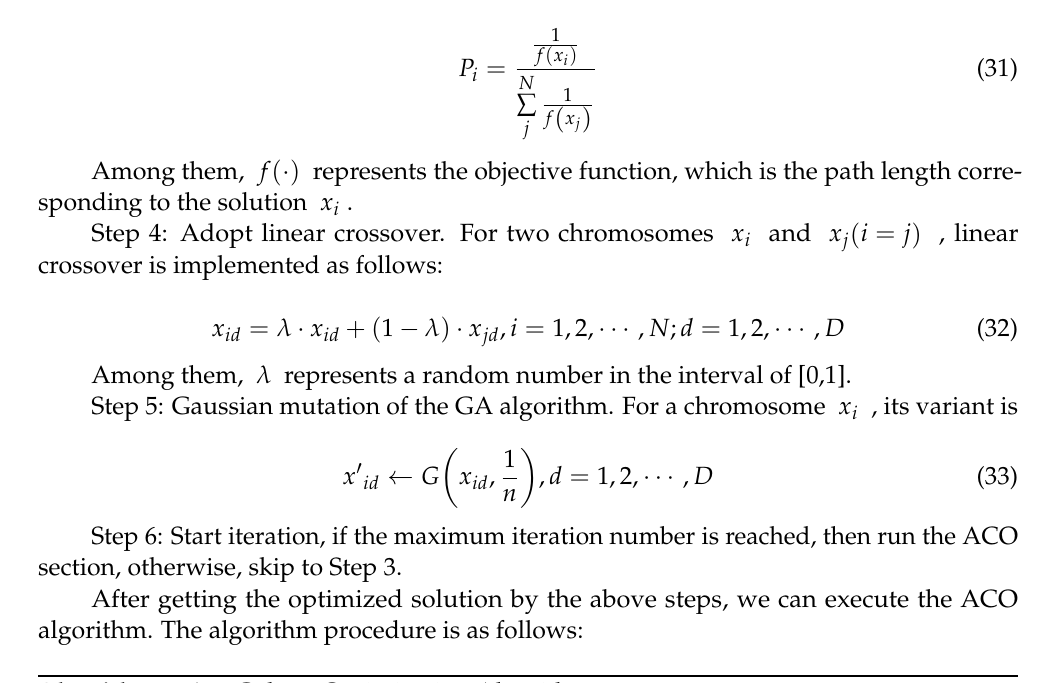
Algorithm 2 Ant Colony Optimization